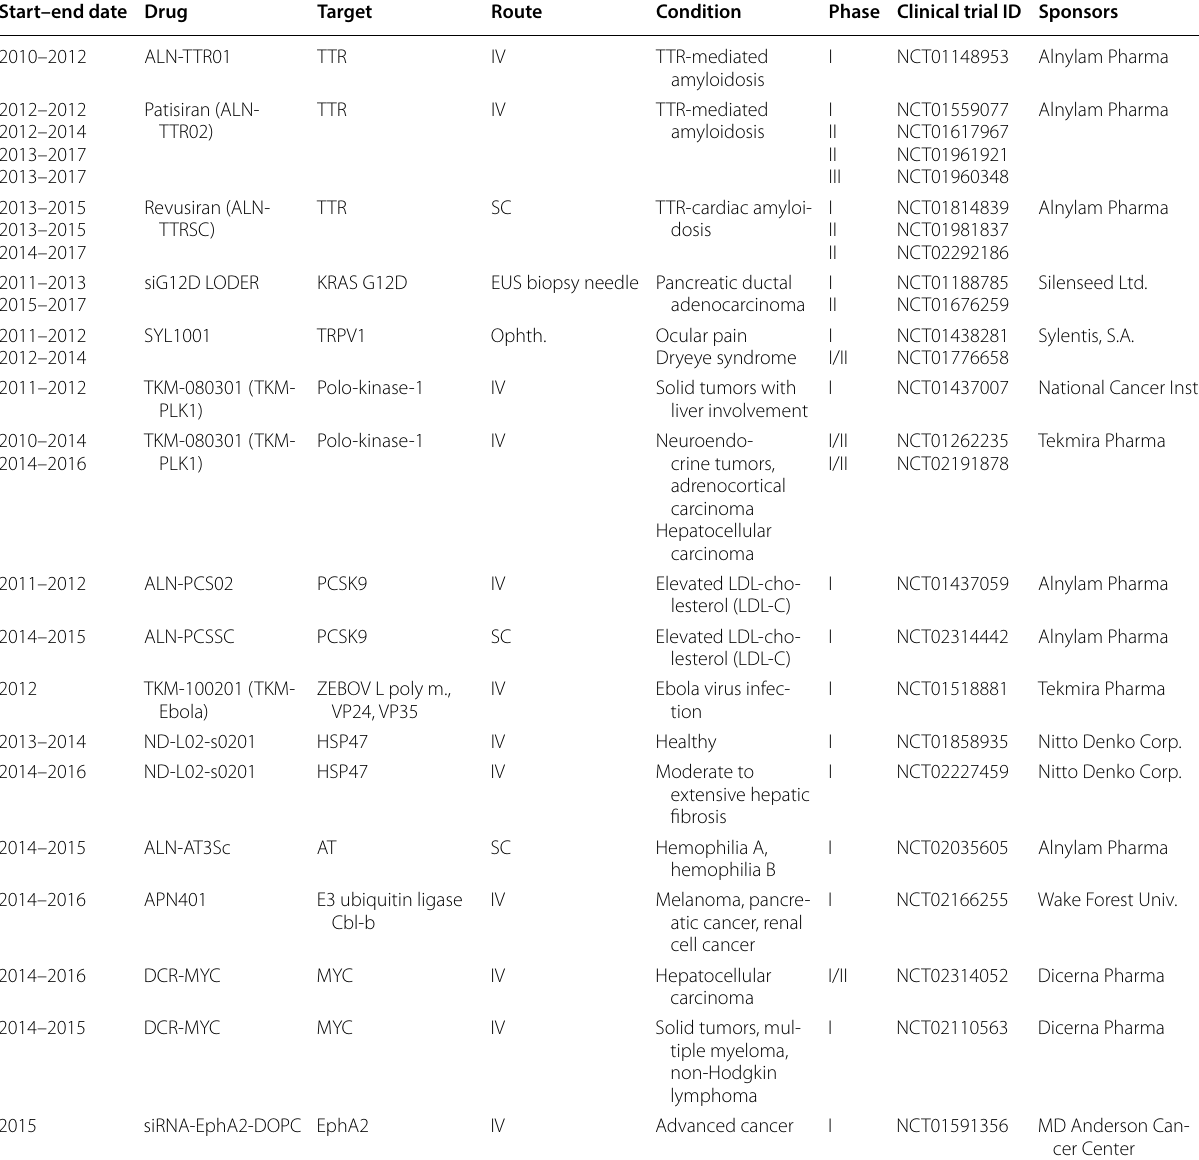
Table 1 siRNA-based therapeutics in clinical trials. Reproduced with permission [23]